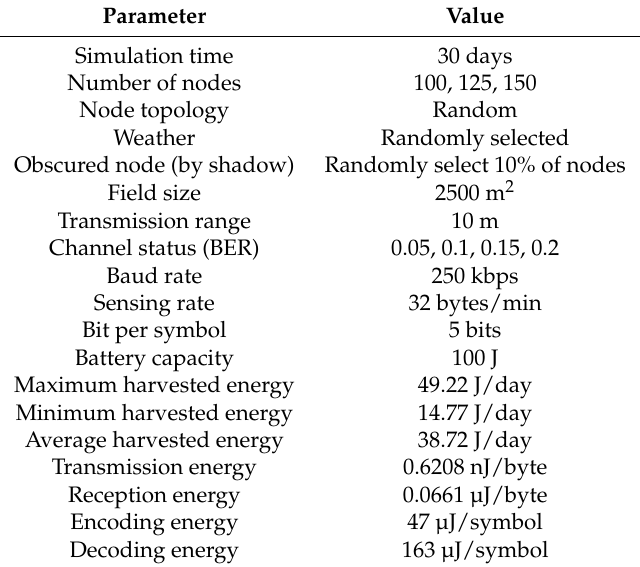
Table 3. Simulation parameters. BER: bit-error